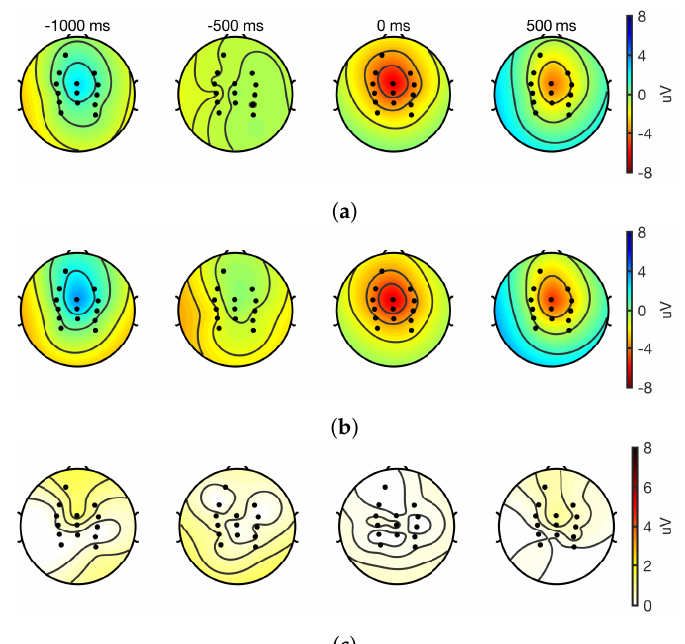
Figure 8. Interpolated topographic maps obtained at different latencies with respect to the movement onset form cleaned EEG epochs ( n = 22); 1022 and 1028 epochs were used for the gold standard and the prototype, respectively. Time at 0 ms corresponds to the movement onset. ( a ) GS; ( b ) Proto; ( c ) Absolute difference of channels from ( a ) and ( b